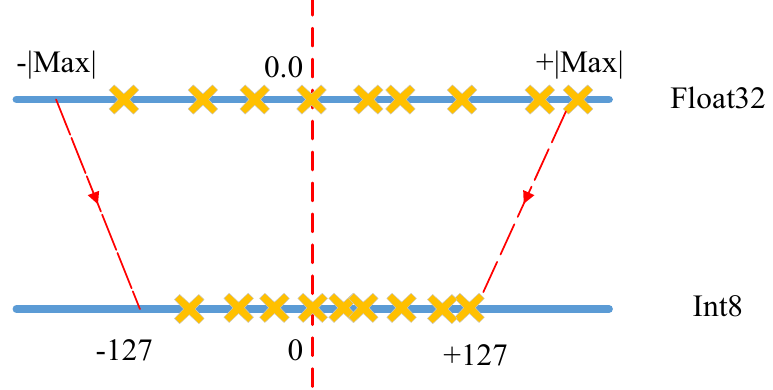
Figure 6. The linear maximum quantization